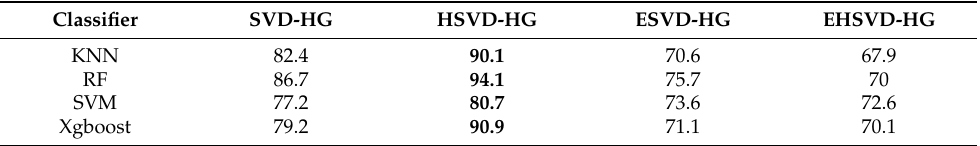
Table 5. Case Study-I: Classifiers Performance when Training and Testing with Different